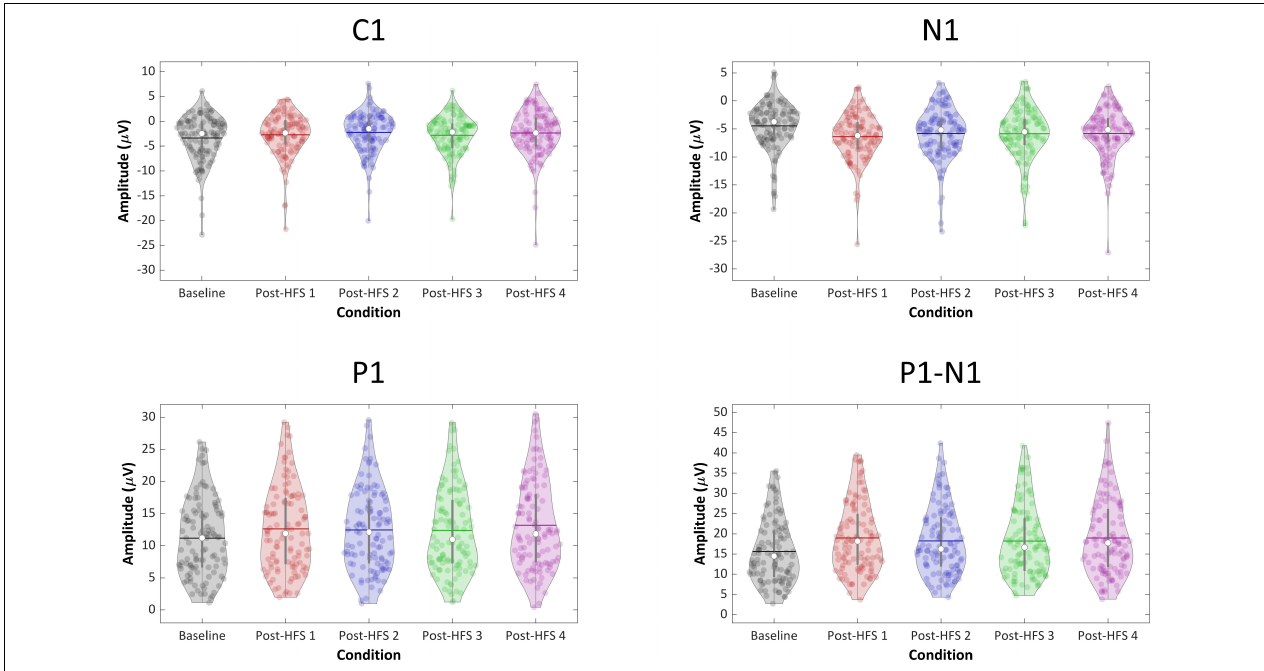
FIGURE 4 | Violin plots of component VEP amplitudes (C1, P1, N1, P1-N1) across